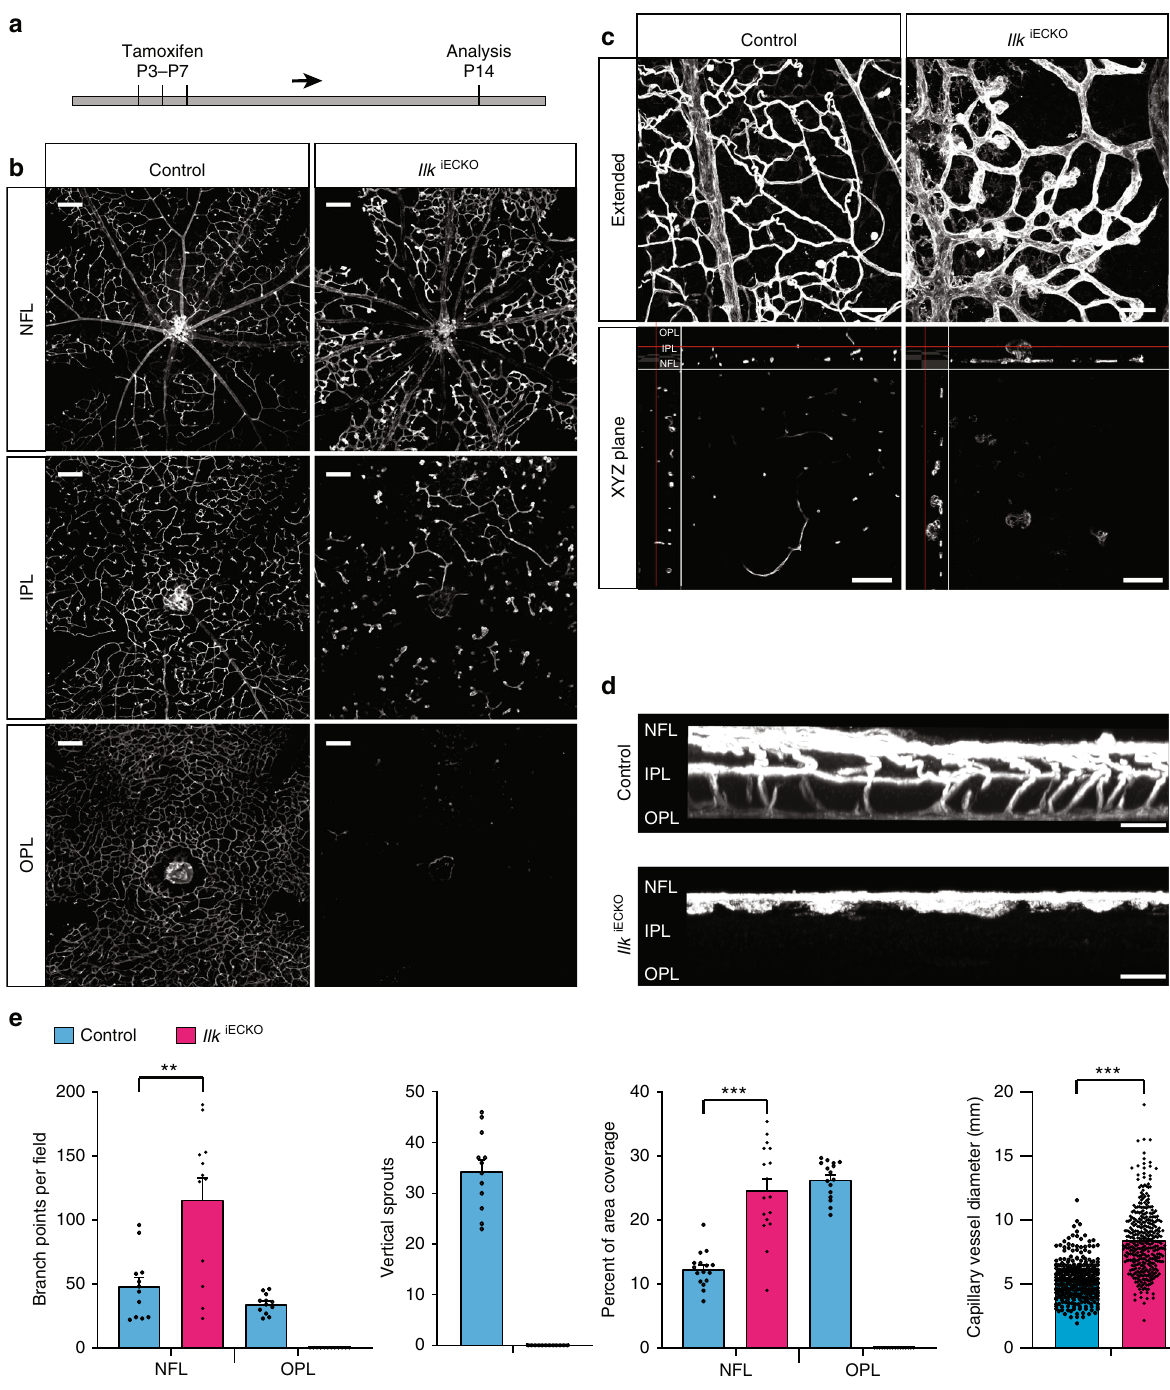
Fig. 2 ILK is indispensable for plexus formation in the deeper retina. a Ilk iECKO mutants and littermate controls received intraperitoneal tamoxifen injections every other day from P3 – 7 and were analyzed at P14. b Isolectin B4-stained Ilk iECKO mutants and littermate control retinas. Optical sections of z-stacked confocal images were divided to represent the nerve fi ber layer (NFL), inner plexiform layer (IPL), and outer plexiform layer (OPL). Note strong reduction of the Ilk iECKO IPL and OPL vasculature. Scale bar, 200 μ m. c , d , XY-extended, ZY-extended, and XYZ plane view high magni fi cation images of control and Ilk iECKO retinas stained with isolectin B4. Vertical sprouting is impaired and abnormal, bulging endothelial structures decorate dilated vessels in Ilk iECKO retinas. Scale bar, 100 μ m (top) and 50 μ m (bottom) in ( c ), 25 µ m in ( d ). e Quanti fi cation of branch points, vascular area coverage, vertical sprouts and capillary vessel diameter, as shown in ( b ) and ( c ). Error bars, s.e.m. p values (*** p < 0.001, ** p < 0.01), Student ’ s t test ( n = 6 retinas/group). Source data are provided as a Source Data fi